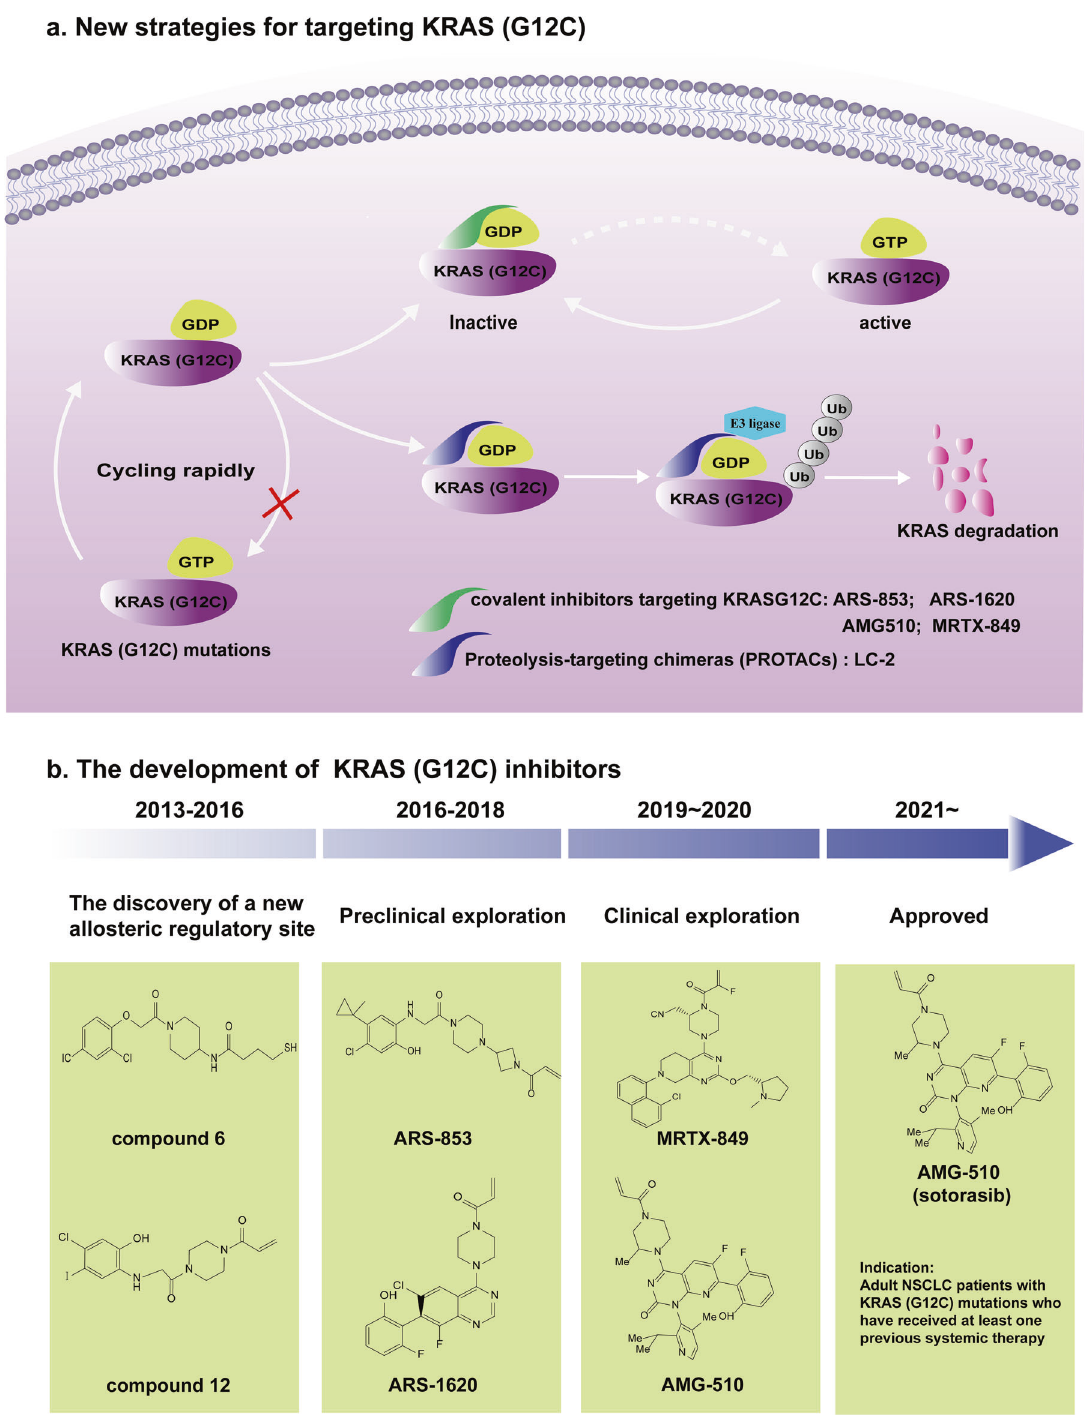
Fig. 5 Current targeted strategies for KRAS (G12C). a Despite the mutation occurring in KRAS, KRAS (G12C) still continues to perform the KRAS-GDP/GTP cycle. Covalent inhibitors such as AMG510 and MRTX849 lock KRAS (G12C) in inactivated GDP-bound state, thus decreasing functional KRAS. Another strategy is to increase the degradation of mutant KRAS (G12C) proteins. Based on the previously described KRAS (G12C) covalent inhibitors, LC-2, an endogenous KRAS (G12C) degrader, has been developed to promote KRAS (G12C) degradation. b